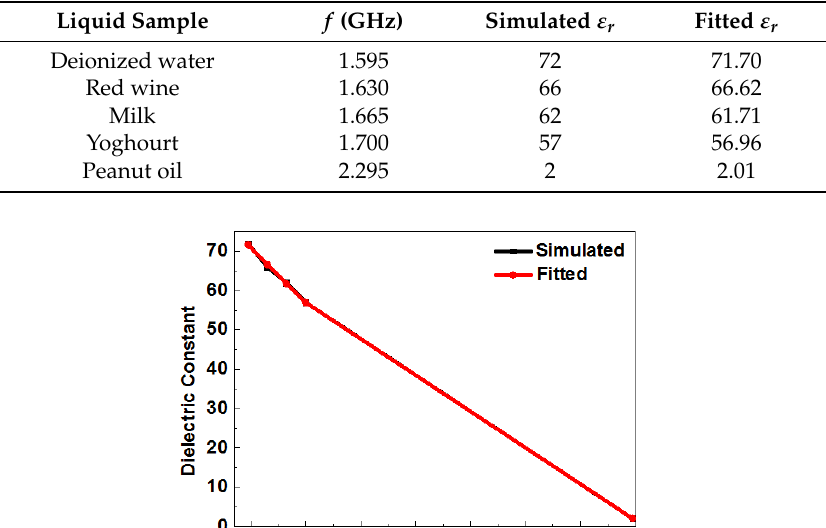
Table 4. Measured resonant frequencies and dielectric constants of liquid samples.